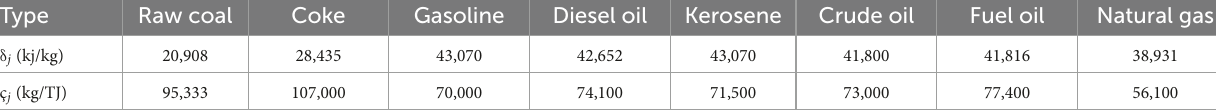
TABLE 3 Average low calorific value and carbon emission coefficient of various energy sources.